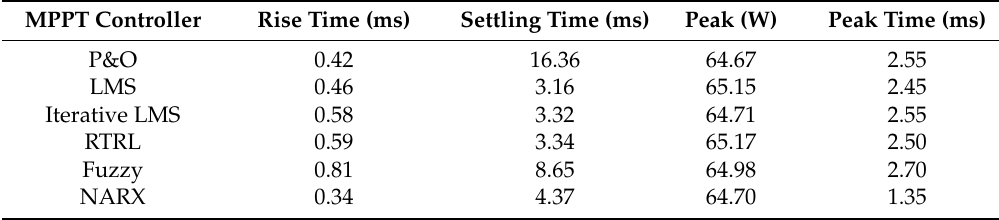
Table 5. Step-response characteristics for a simulation time of 0.025